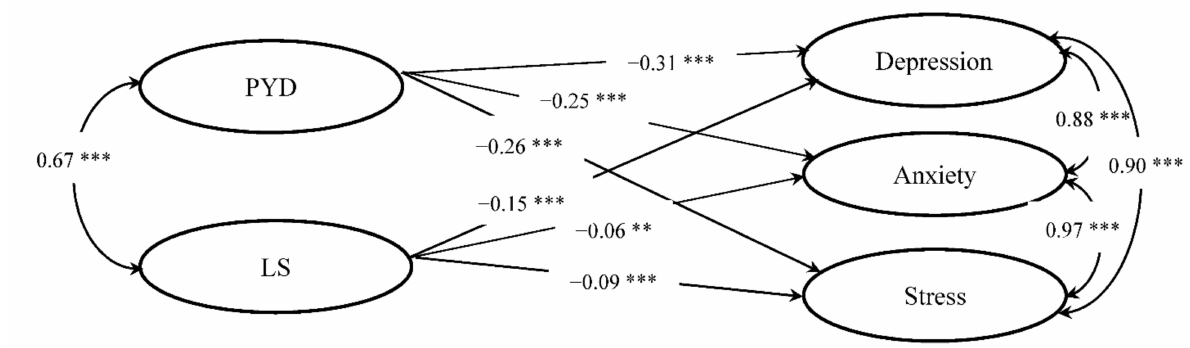
Figure 2. Structural equation model. Note. Latent constructs are shown in ellipses. PYD = positive youth development; LS = life satisfaction. ** p < 0.01; *** p <